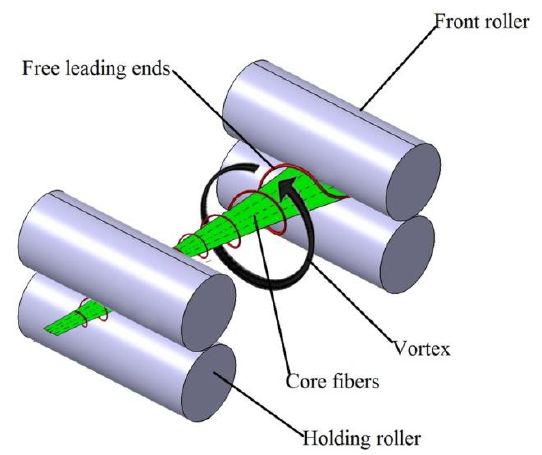
Figure 5. The pre-twisting process.